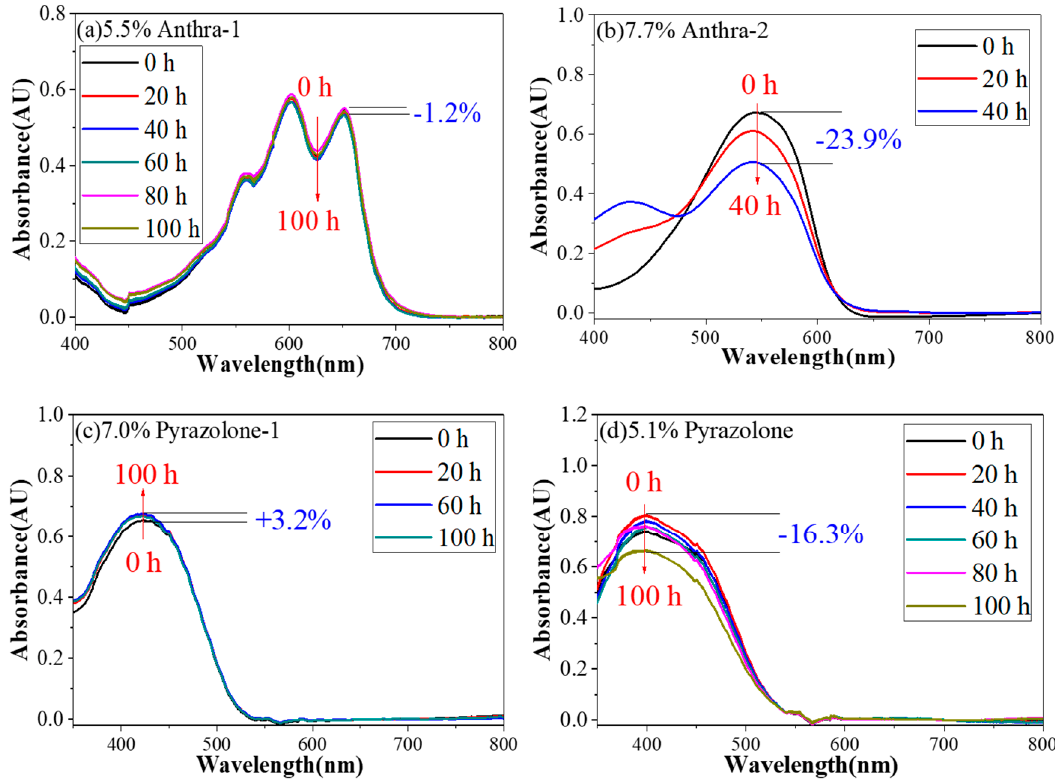
Figure 5. Photo-stability test results of four formulated dyes. (Irradiation condition: 0.55 W/m 2 (340 nm); Temperature 45 °C). ( a ) 5.5% Anthra-1, ( b ) 7.7% Anthra-2, ( c ) 7.0% Pyrazolone-1, ( d ) 5.1% Pyrazolone The color coordinates (x, y) of colored EFD cell in CIE1931 color space and color deviation Δ E